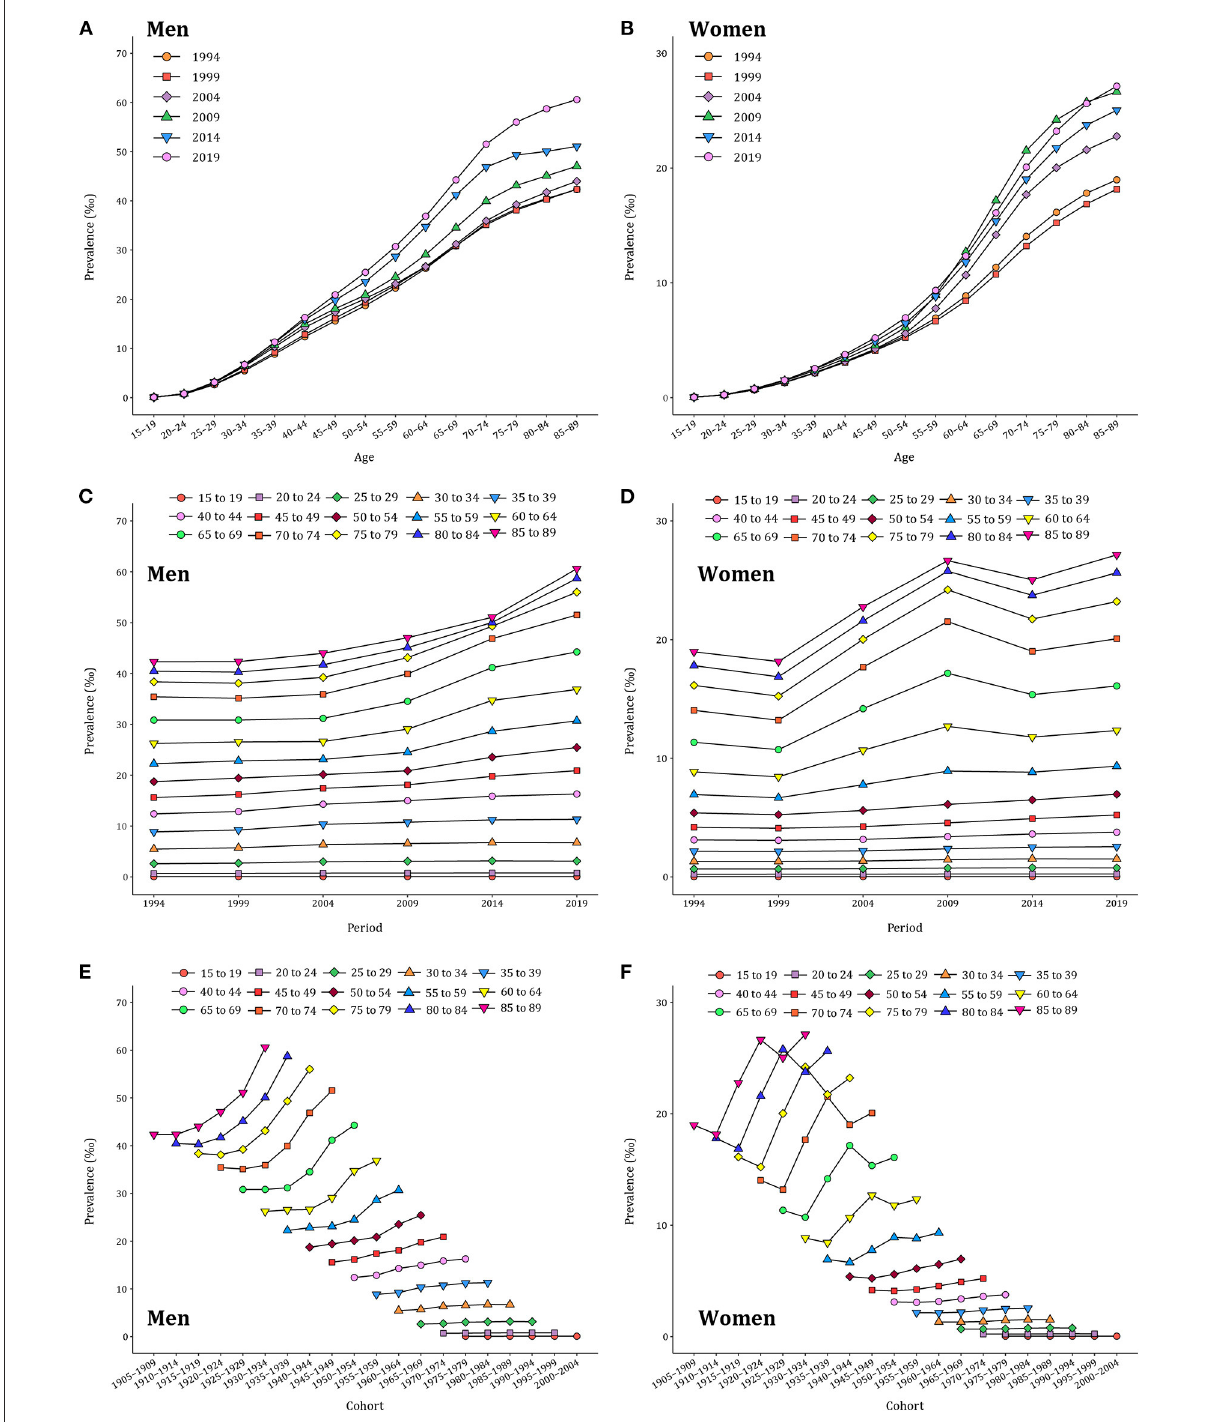
FIGURE2 Long–term trends of age–specific, period–based, and cohort–based variation of gout prevalence in China during 1990–2019. (A,B) Age–specific prevalence of gout for men and women. (C,D) Period–based prevalence of gout for men and women. (E,F ) Cohort–based prevalence of gout for men and